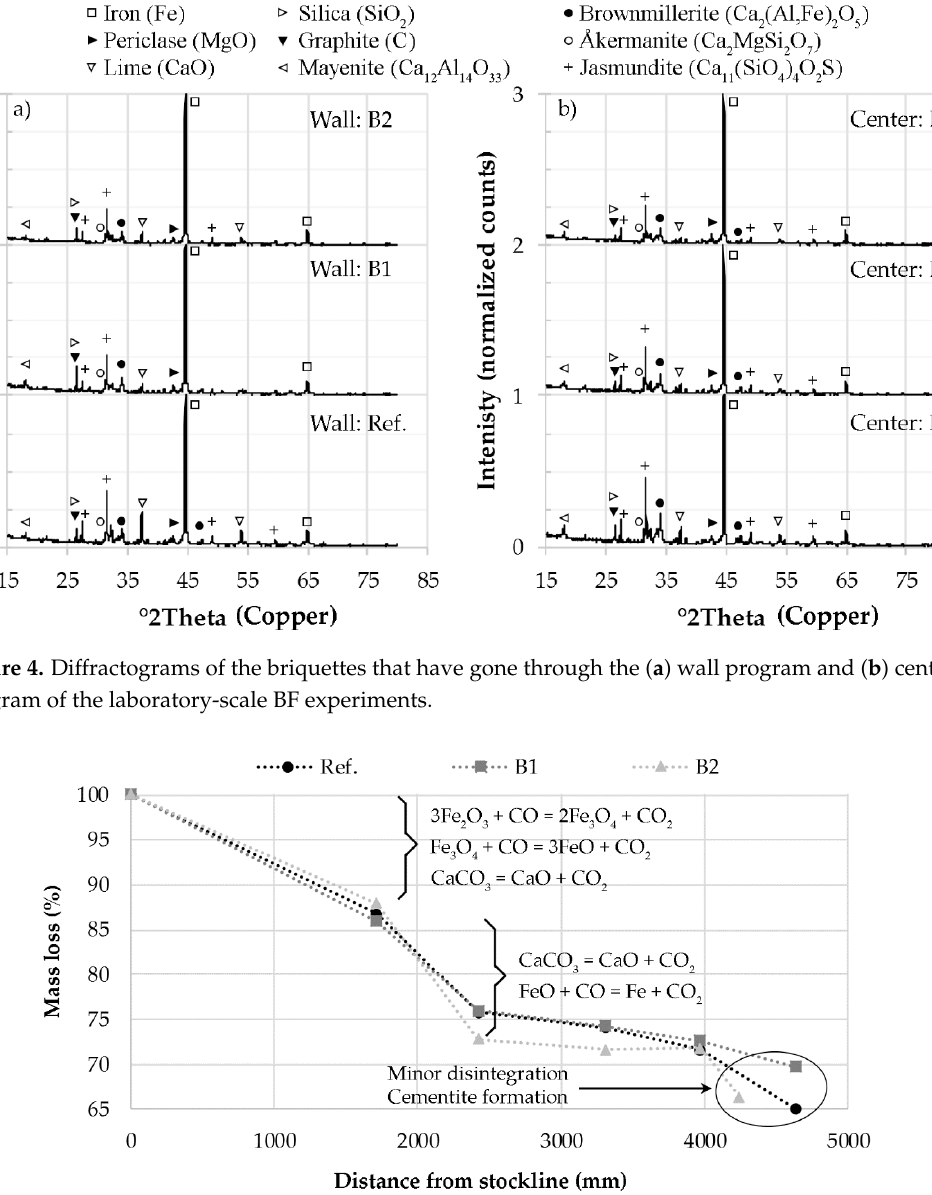
Figure 4. Diffractograms of the briquettes that have gone through the ( a ) wall program and ( b ) center program of the laboratory-scale BF experiments.